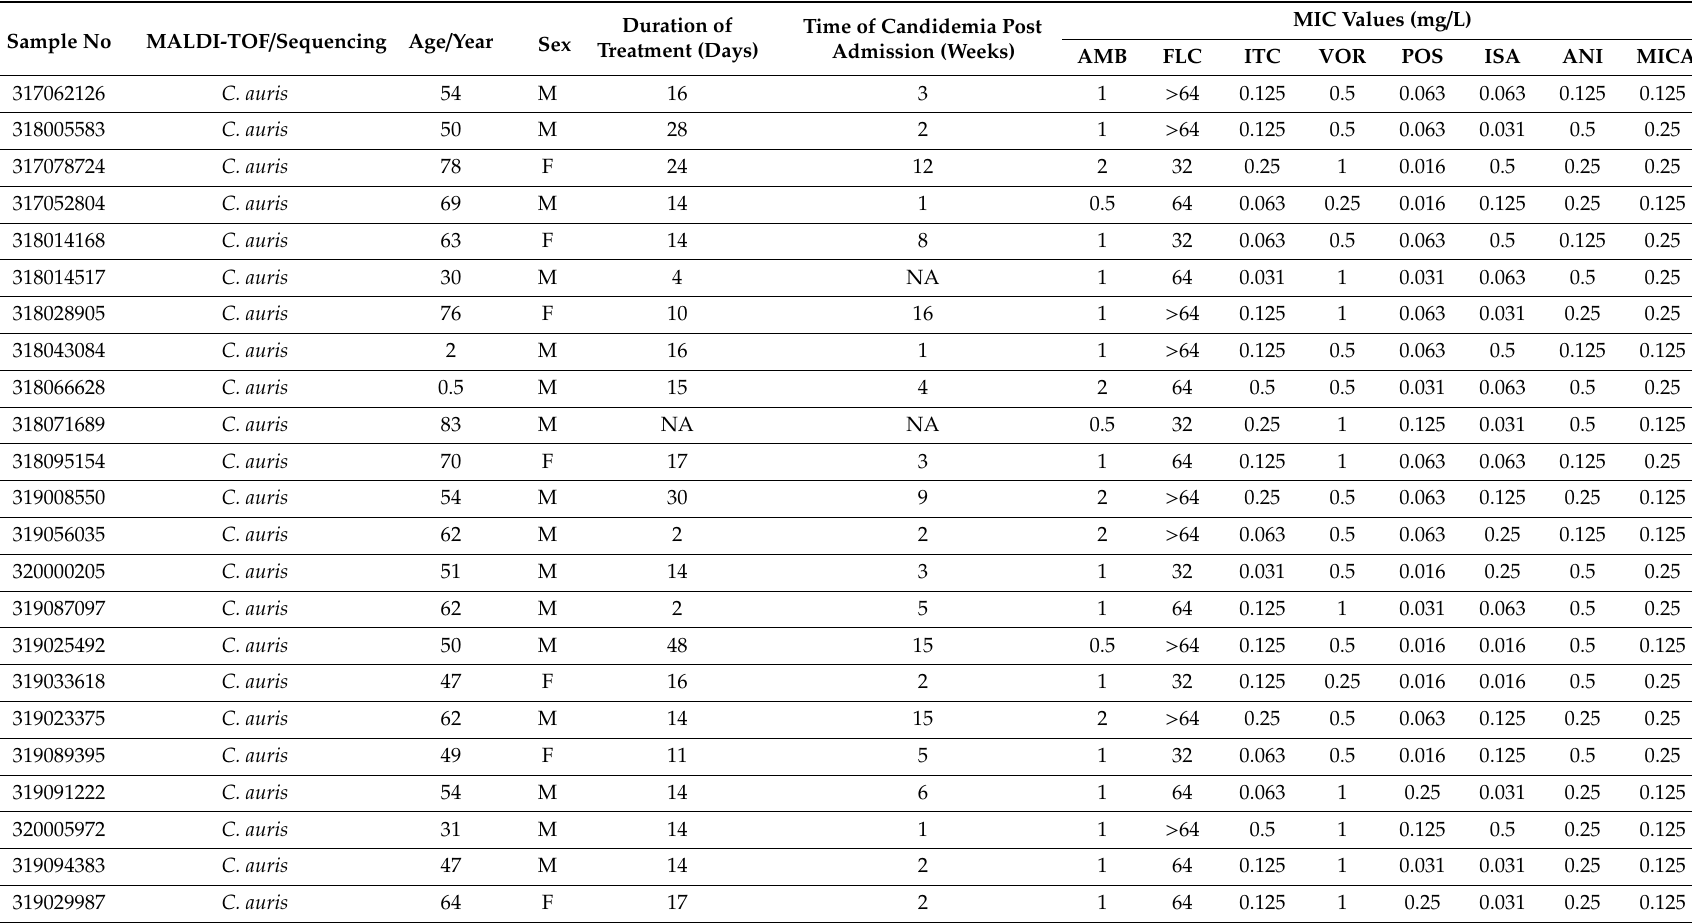
Table 1. Demographic data of patients, identification and antifungal susceptibility